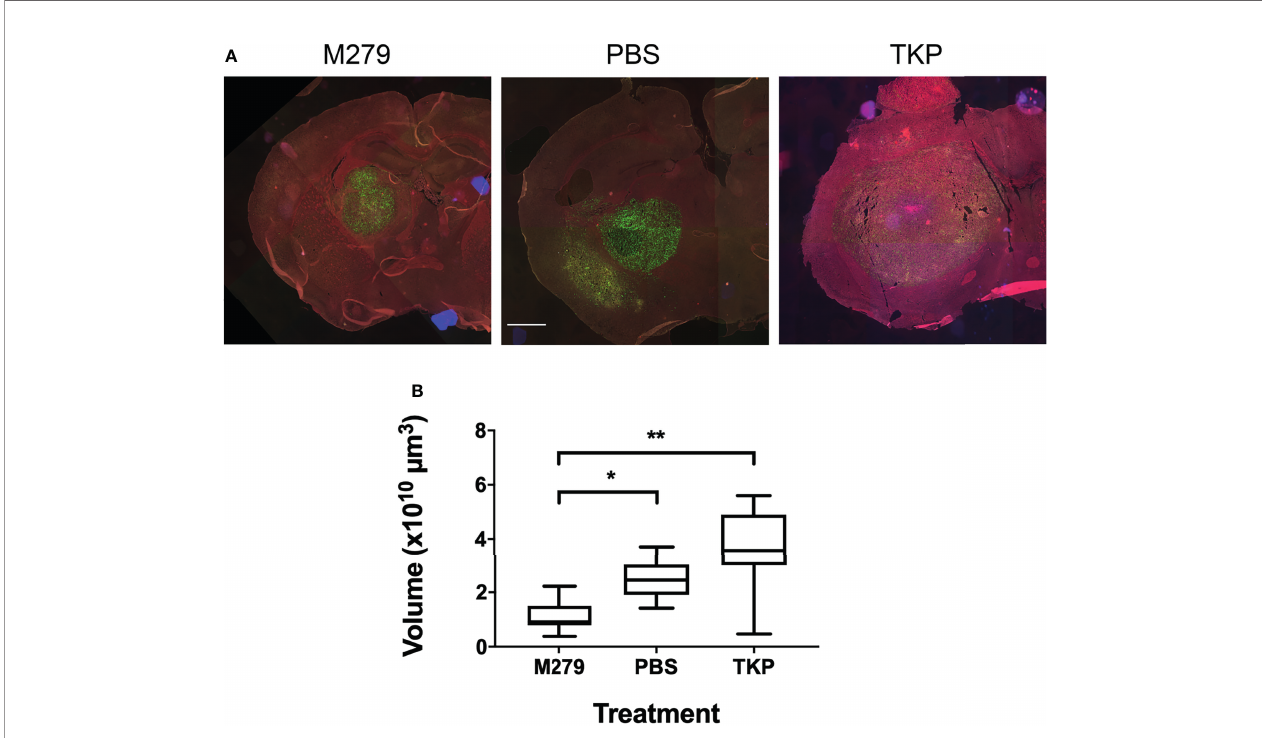
FIGURE 5 | Effect of TKP and M279 treatment on tumour volume. (A) Representative images of brain sections from M279 (CSF-1R mAb), PBS and TKP treated mice. Scale bar = 1 mm. (B) Graph of tumour volumes in M279 (n = 7), PBS (n = 7) and TKP (n = 8) treated groups. Data shown as box and whisker plots depicting full range of data points. *p < 0.05, **p <